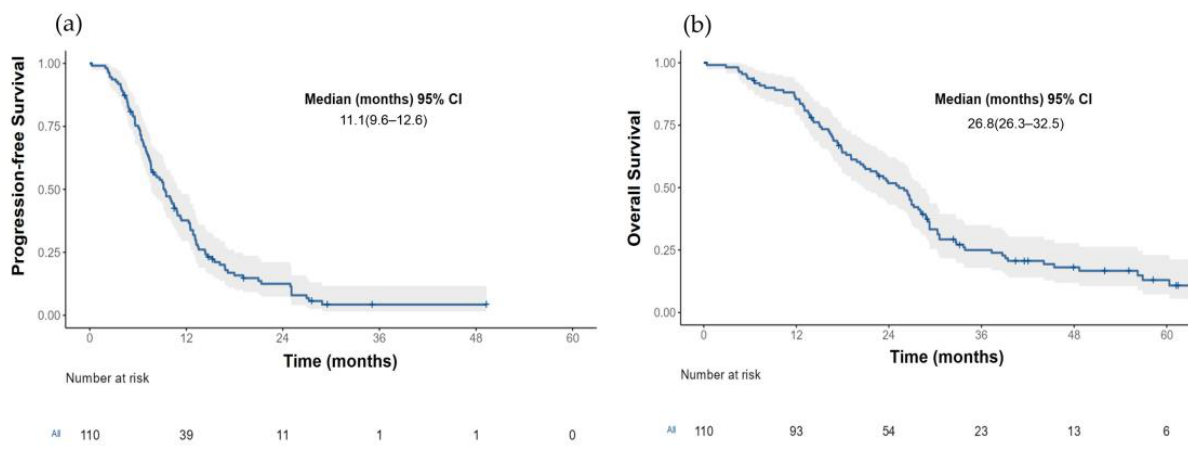
Figure 2. ( a ) Progression free survival and ( b ) Overall survival in the total population. After an adjustment for the EGFR status (wild-type versus mutant) and type of treat- ment (first- and second-generation EGFR-TKI vs. platinum-based chemotherapy). The median PFS continued to be significantly larger in those patients with a positive LKB1 expression, especially between EGFR mutant patients versus wild-type; Figure 3c.